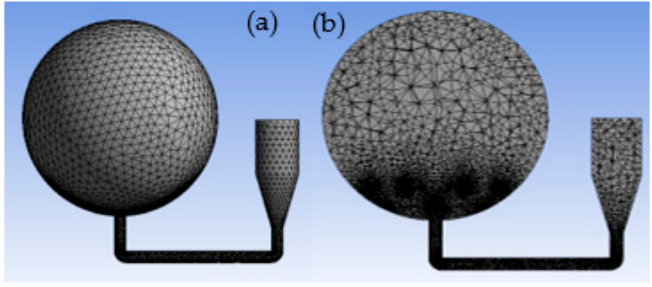
Figure 4. Meshing results ( a ) before and ( b ) after adaptive mesh refinement.